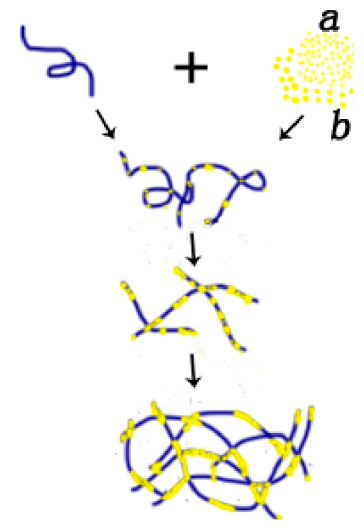
Figure 6. Schematic for p53–DNA binding. ( a ) Firstly, some p53 molecules spontaneously adhere to one DNA molecule by Brownian movement or electrostatic interaction. Secondly, the other free p53 molecules integrate with some p53 molecules adhering on one DNA, under a certain magnesium effect. And, the other free p53 molecules integrate with p53 adhering on one DNA, repeatedly. Thirdly, some p53 molecules adhering to DNA connect with the other p53 adhering to DNA, forming large-scale networks; ( b ) Initially, some p53 molecules integrate with other p53, under the magnesium effect. After that, some p53 aggregations adhere to one DNA molecules. Finally, p53 makes it possible to spontaneously link p53 under the magnesium effect, forming large-scale networks, repeatedly. Note that: ( a ) is related to the top part of protein (small yellow beads in the right of first line); ( b ) is related to the bottom part of protein (big yellow beads in the right of first line).